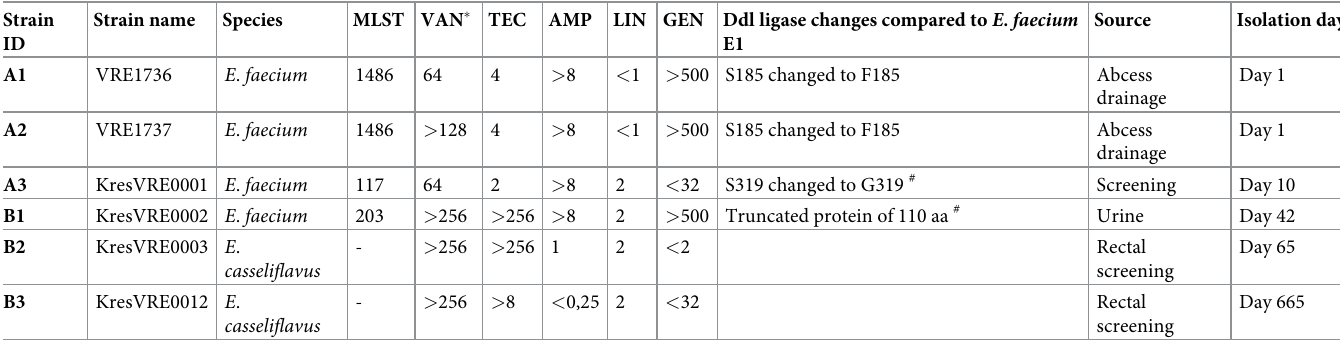
Table 2. Relevant strain